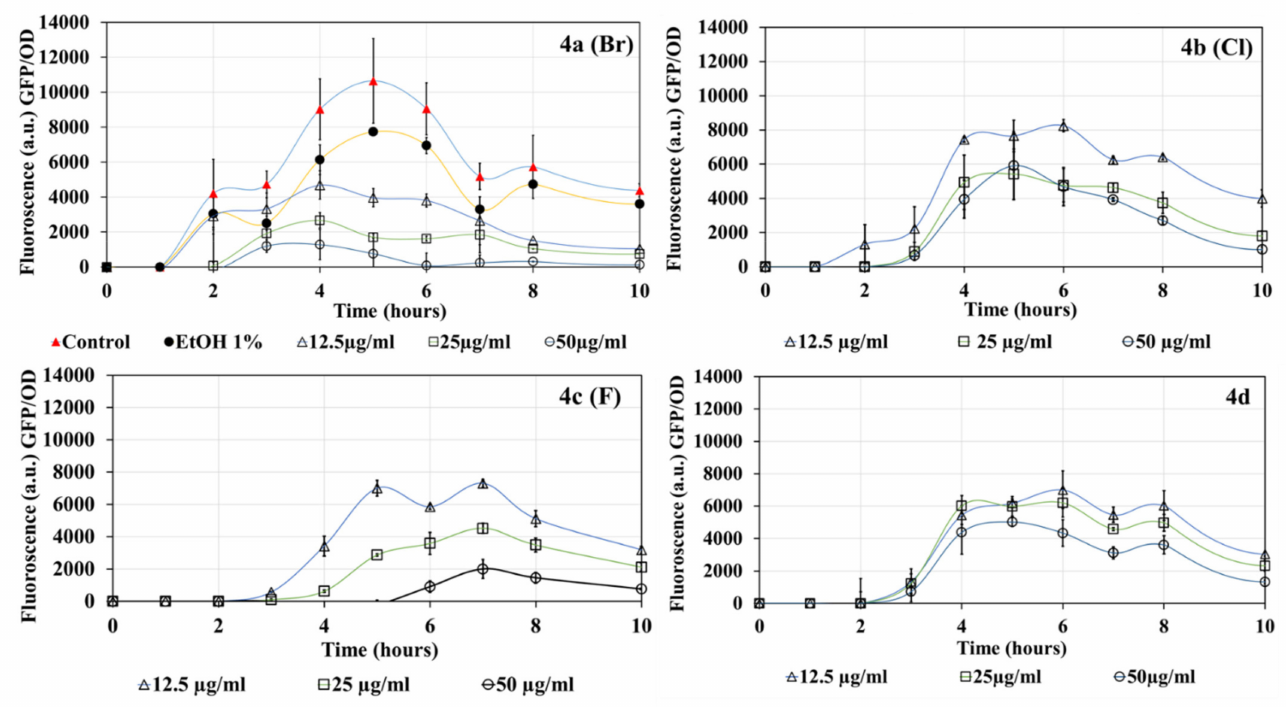
Figure 3. Effects of DHP compounds on PQS-linked GFP production by P. aeruginosa